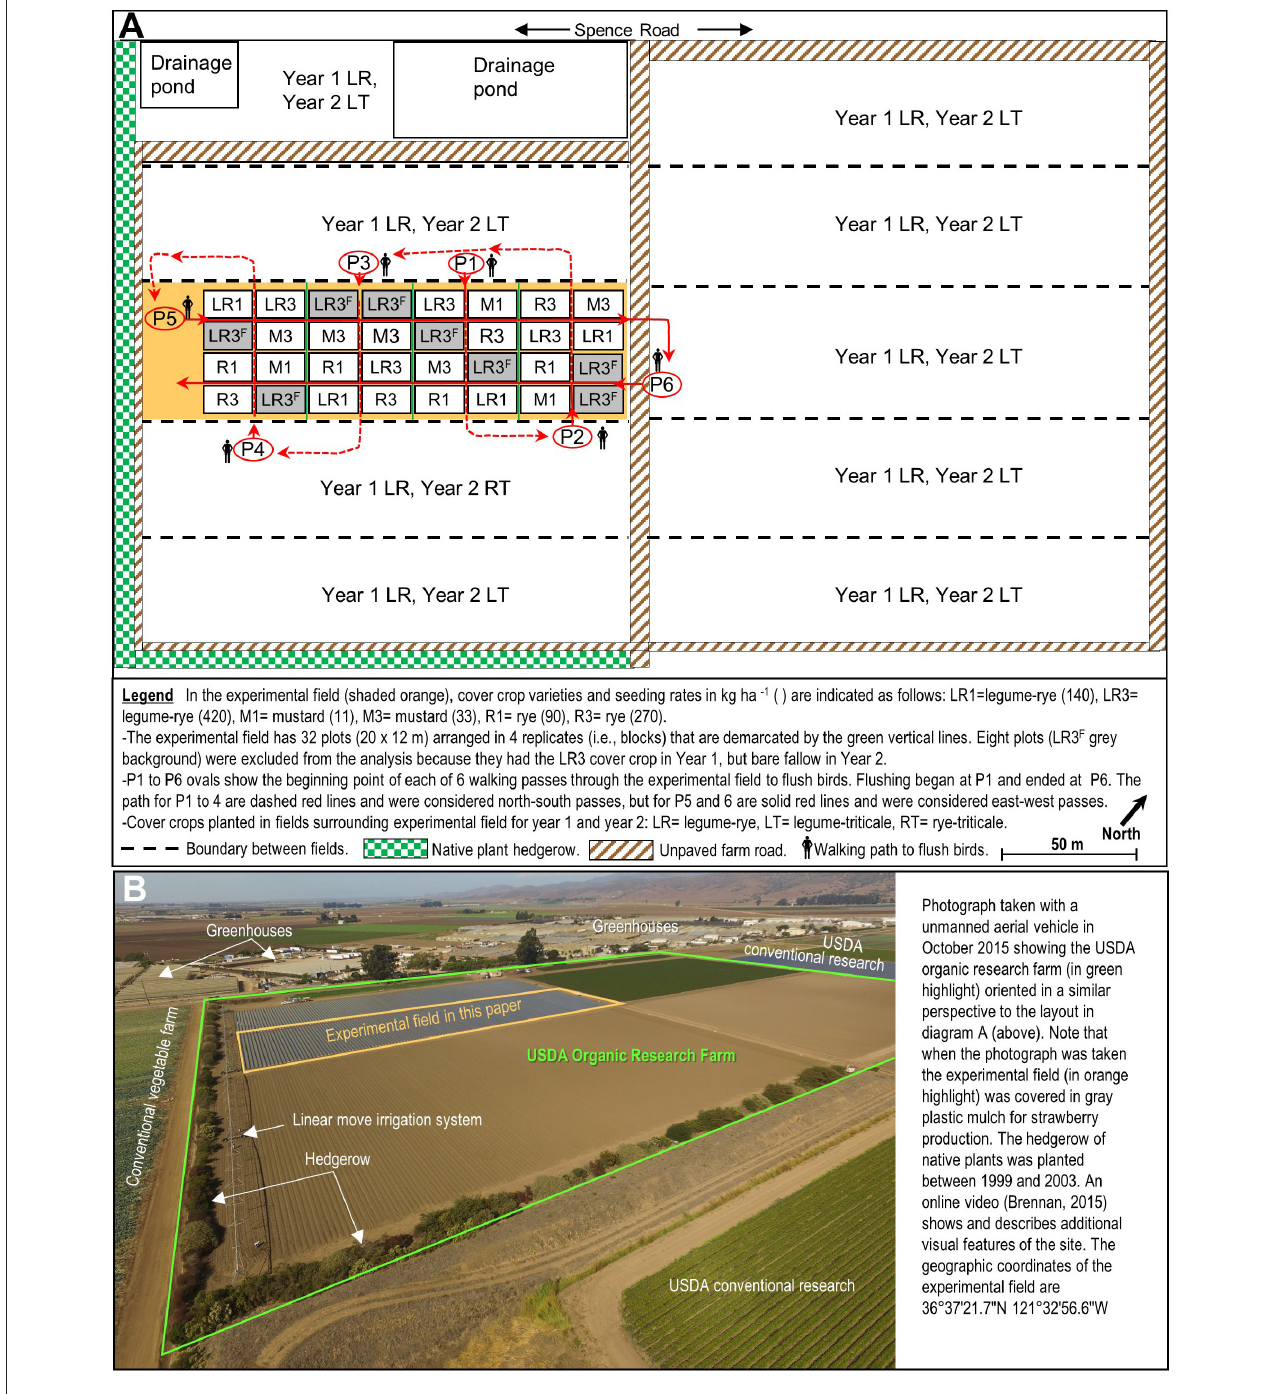
FIGURE 1 | Layout of the agricultural fields (A) at the 10 ha USDA organic research farm along Spence Road in Salinas, California including the 0.9 ha field (shaded orange) where the effect of cover crops on sparrows was studied during two winter periods. The photograph (B) provides an aerial view of the organic research farm (in green highlight) and surrounding